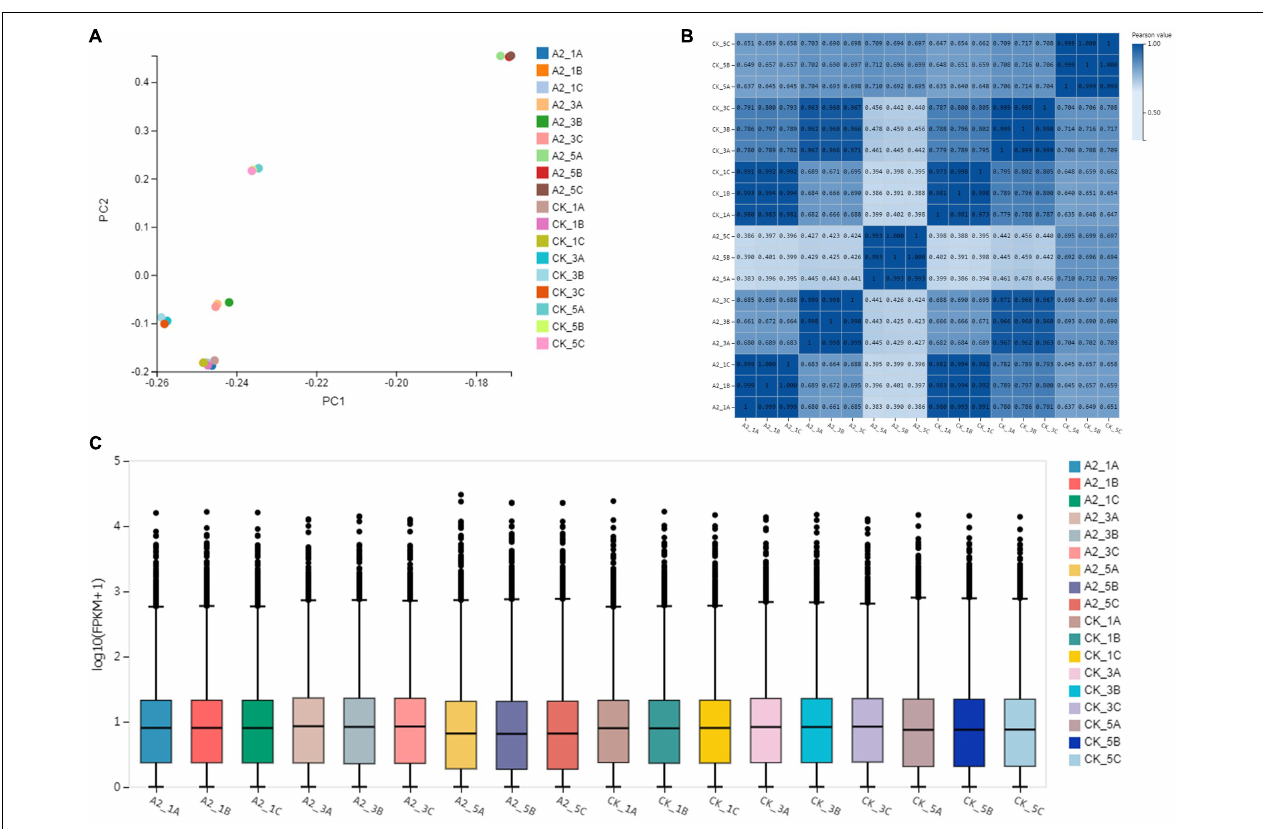
FIGURE 2 | Transcriptome at 0, 4, and 8 weeks after treatment with 0 and 20 µ M ABA. (A) Principal component analysis of six samples. (B) Pearson correlation coefficient of gene expression levels between samples. (C) Distribution of gene expression levels in each sample. The x -axis shows the sample name, and the y -axis shows log10 [FPKM (fragments per kilobase of exon model per million mapped reads) + 1]. The box plot for each region corresponds to five statistics (upper to lower, upper quartile, median, and lower quartile, lower limit, where the upper and lower limits do not take outliers into account).